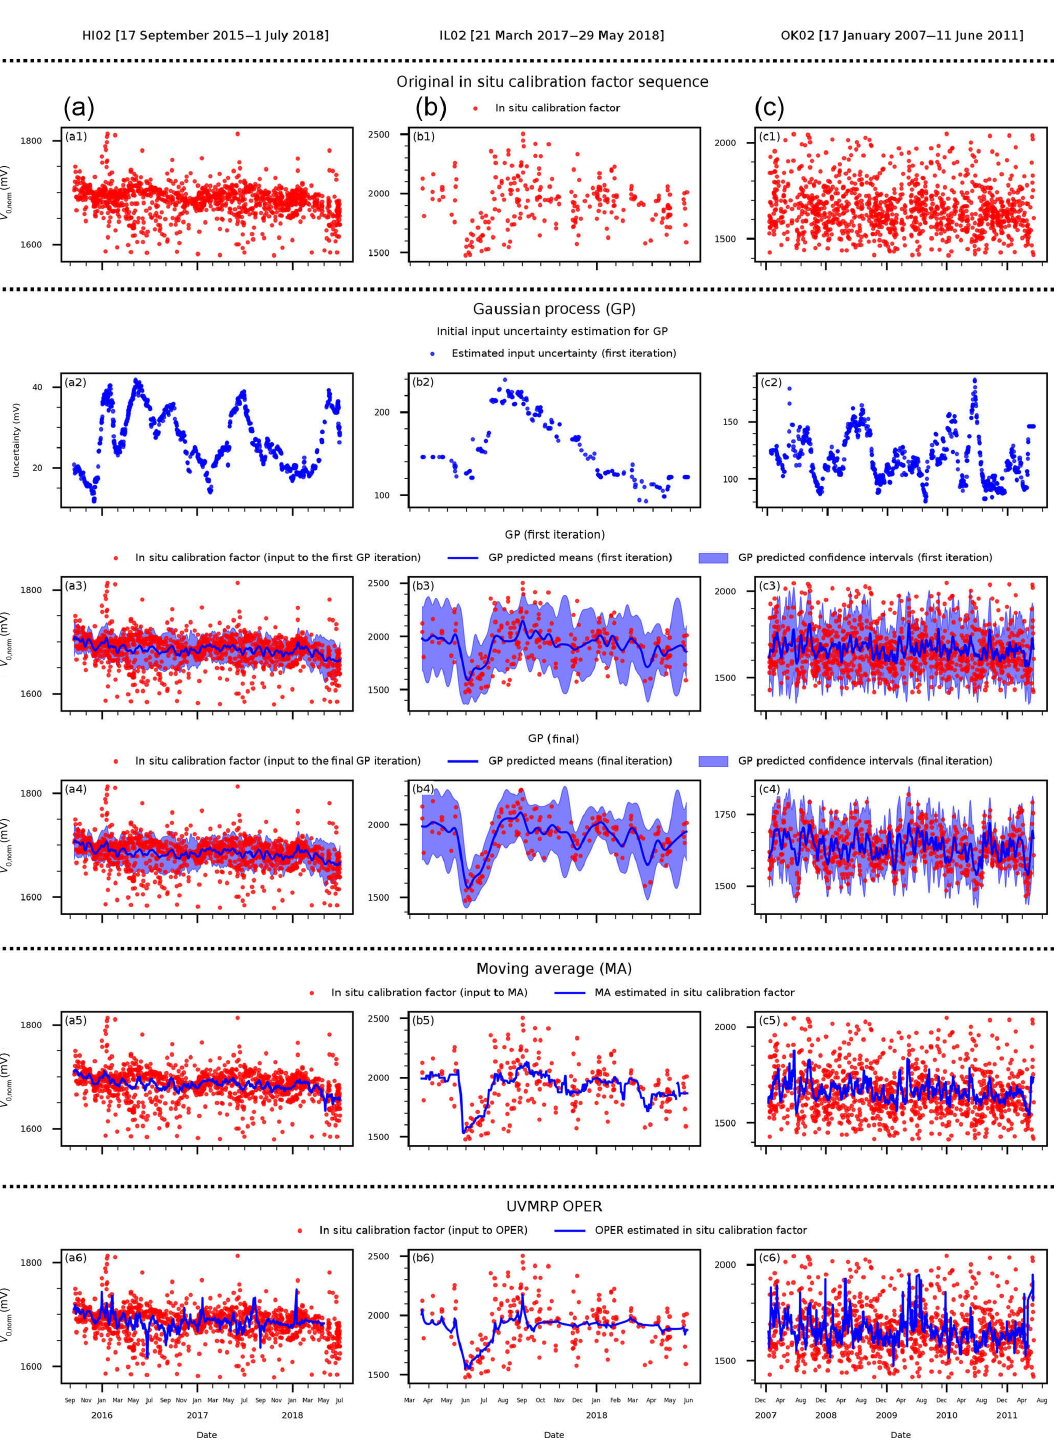
Figure 3. The results of the three smoothing methods (i.e., GP – Gaussian process; MA – moving average; OPER – UVMRP operational algorithm) for the three UVMRP in situ calibration factor sequences: (a) HI02 (17 September 2015 to 1 July 2018), (b) IL02 (21 March 2017 to 29 May 2018), and (c) OK02 (17 January 2007 to 11 June 2011). Panels (a1) , (b1) , (c1) display the original in situ calibration factor ( V 0 , norm ) sequence. Panels (a2) , (b2) , (c2) show the initial input uncertainty estimated for GP. Panels (a3) , (b3) , (c3) present the predicted daily mean and confidence interval from the first iteration of GP. Panels (a4) , (b4) , (c4) show the final results of GP after iterations. Panels (a5) , (b5) , (c5) show the results of MA. Panels (a6) , (b6) , (c6) show the results of